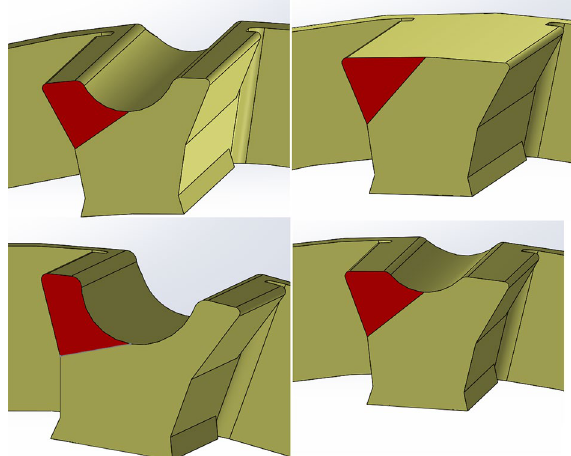
Figure 7. Region of significant deformation.